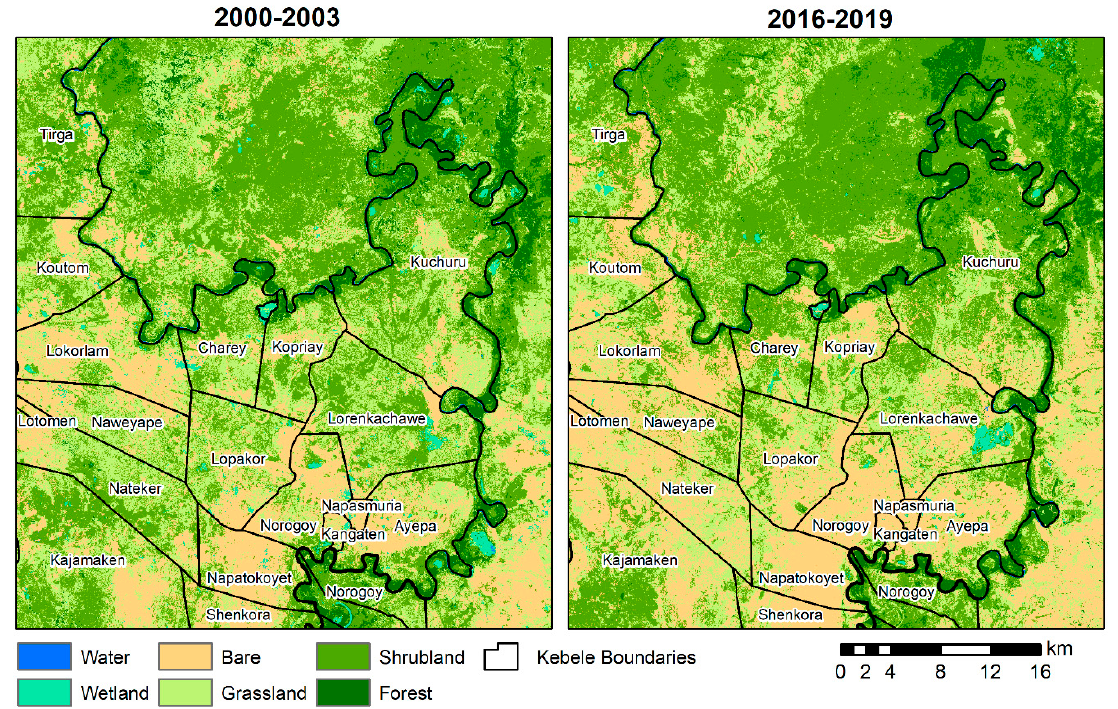
Figure 5. Land cover maps for 2000–2003 and 2016–2019 for kebeles in Nyangatom, South Omo Zone, Ethiopia, derived using Sentinel-2 imagery and k-means unsupervised clustering.